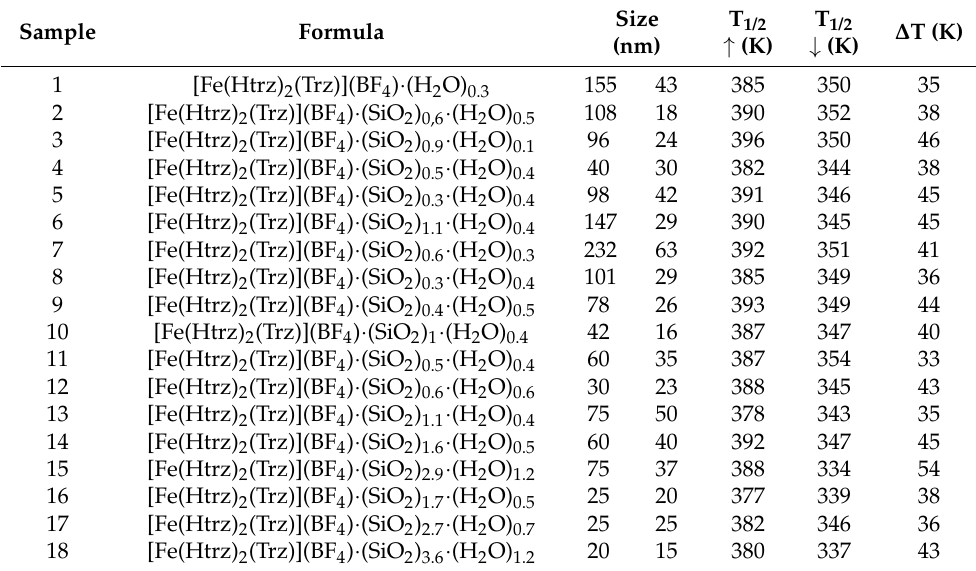
Table 2. Composition, morphological and spin crossover properties extracted from optical measure- ments for nanoparticle samples